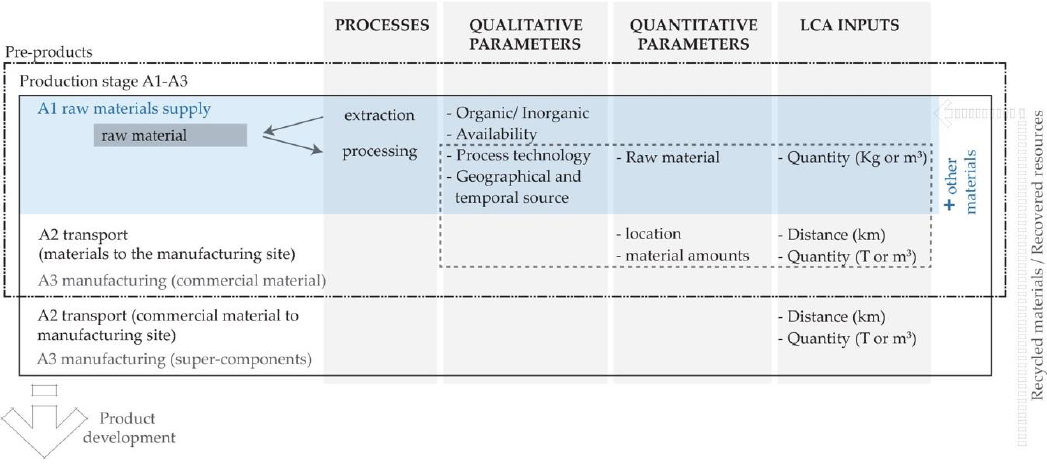
Figure 6. Mapping of LCA parameters for AMs in the phase A1-A2.